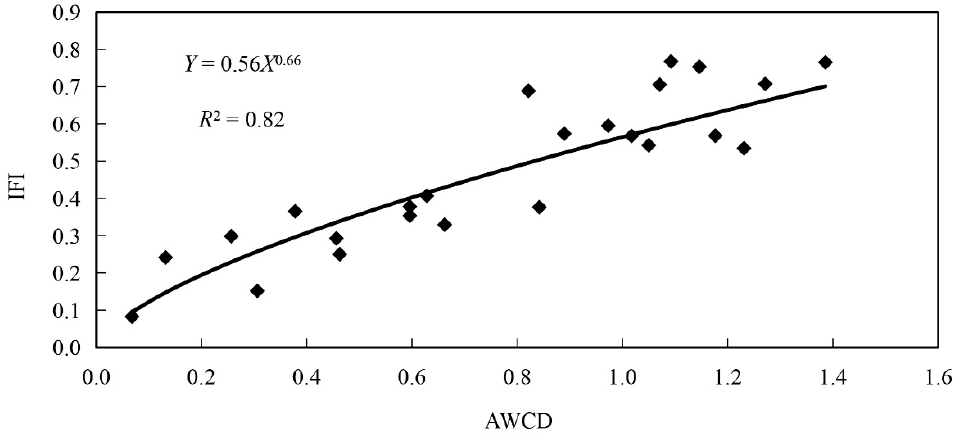
Figure 3. The relationship between the metabolic diversity of soil microorganisms and soil fertility.